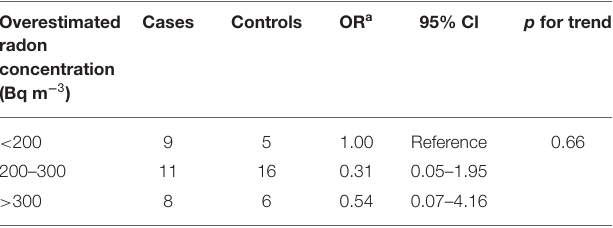
TABLE 3 | Distribution of subjects and OR s for lung cancer according to overestimated radon concentration. Overestimated